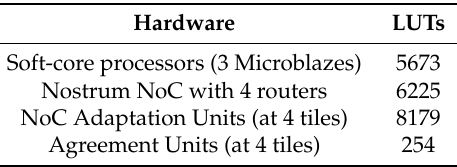
Table 2. FPGA resource